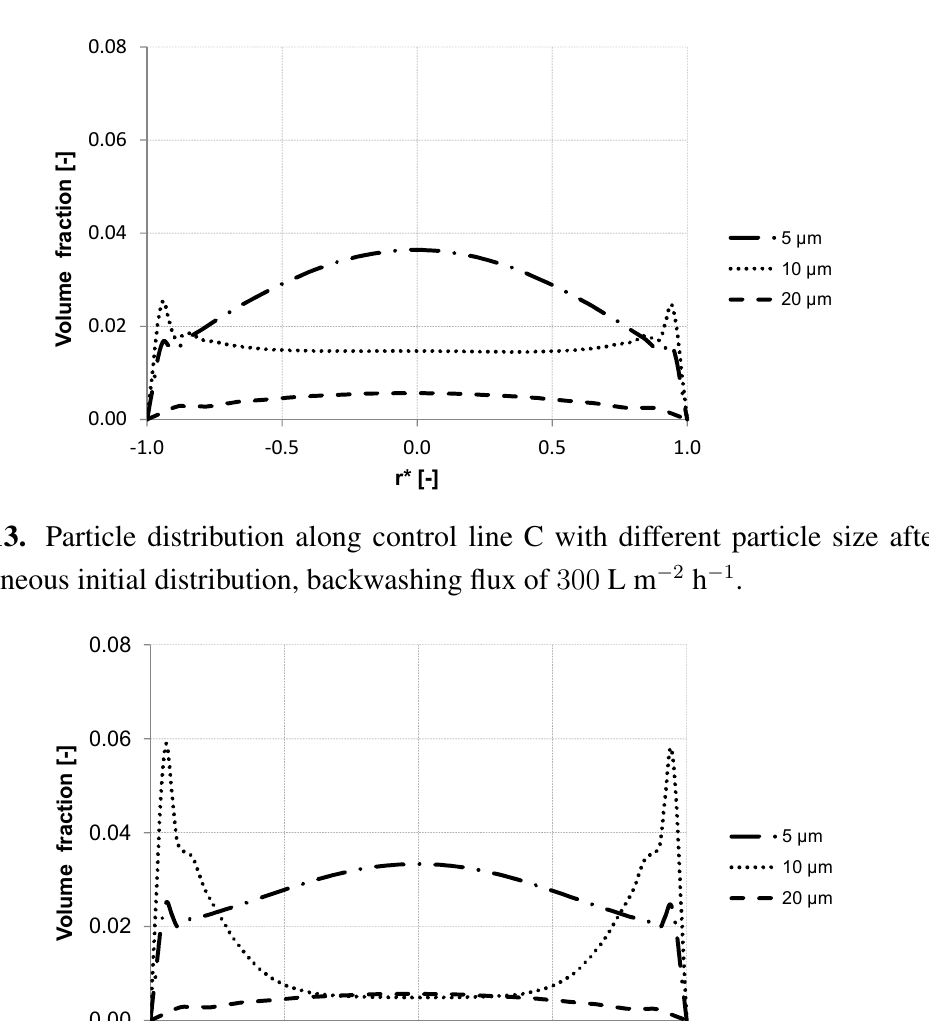
Figure 12. Particle distribution along control line B with different particle size after 5 s (homogeneous initial distribution, backwashing flux of 300 L m − 2 h − 1 .